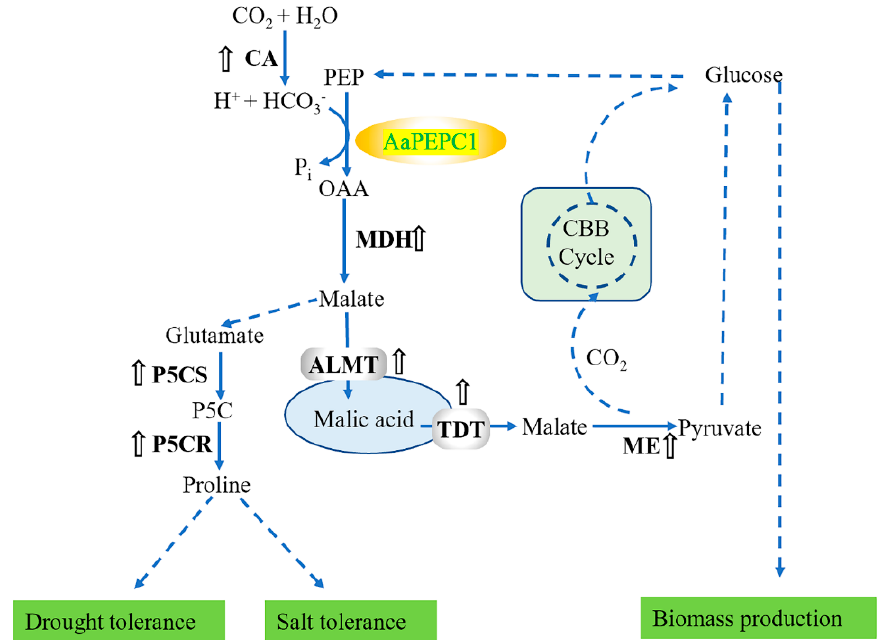
Figure 9. Regulation of photosynthetic CO 2 -fixation and abiotic stress tolerance in the ‘turbocharging’ plants with the AaPEPC1 . Overexpression of the AaPEPC1 , a highly abundant enzyme catalyzing the primary fixation of CO 2 in CAM plants, increases photosynthetic CO 2 -fixation, and rewires the diel accumulation-depletion pattern of malate and glucose. The re-programed malate-dependent carboxylation leads to the feedback up-regulation of the orthologs of key CAM pathway genes, i.e., nocturnal carboxylation and diurnal decarboxylation modules. The increased malate content up-regulates pyrroline-5-carboxylate synthase (P5CS) and pyrroline-5-carboxylate reductase (P5CR), which results in higher proline accumulation. Proline accumulation enhances the salt and drought tolerance of the transgenic plants expressing AaPEPC1 . Additionally, a higher glucose content produced from the photosynthetic source is transported as sucrose or glucose to sink tissues and organs to promote cell proliferation, elongation, and expansion, as well as to maintain energy and metabolic homeostasis, resulting in improved biomass production [64,65]. The up arrows indicate up-regulation of expression of genes coding these enzymes or content. CA: carbonic anhydrase; OAA: oxaloacetate; MDH: malate dehydrogenase; ALMT: aluminum-activated malate transporter; TDT: tonoplast dicarboxylate transporter; ME: malic enzyme; PEP: phospho enol pyruvate; and